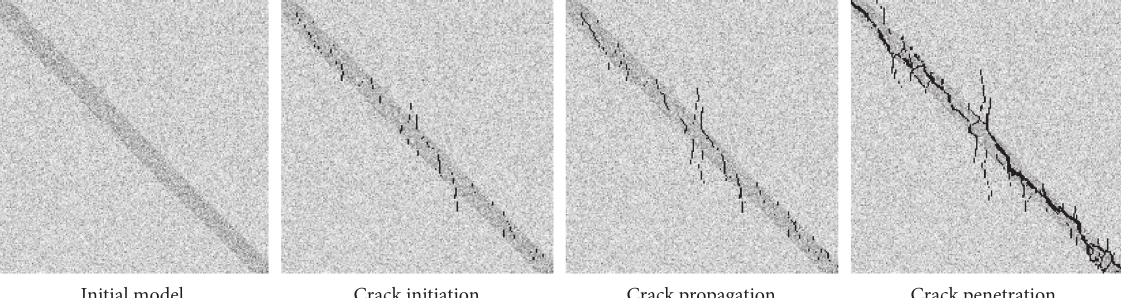
Figure 20: Fracture process of single joint